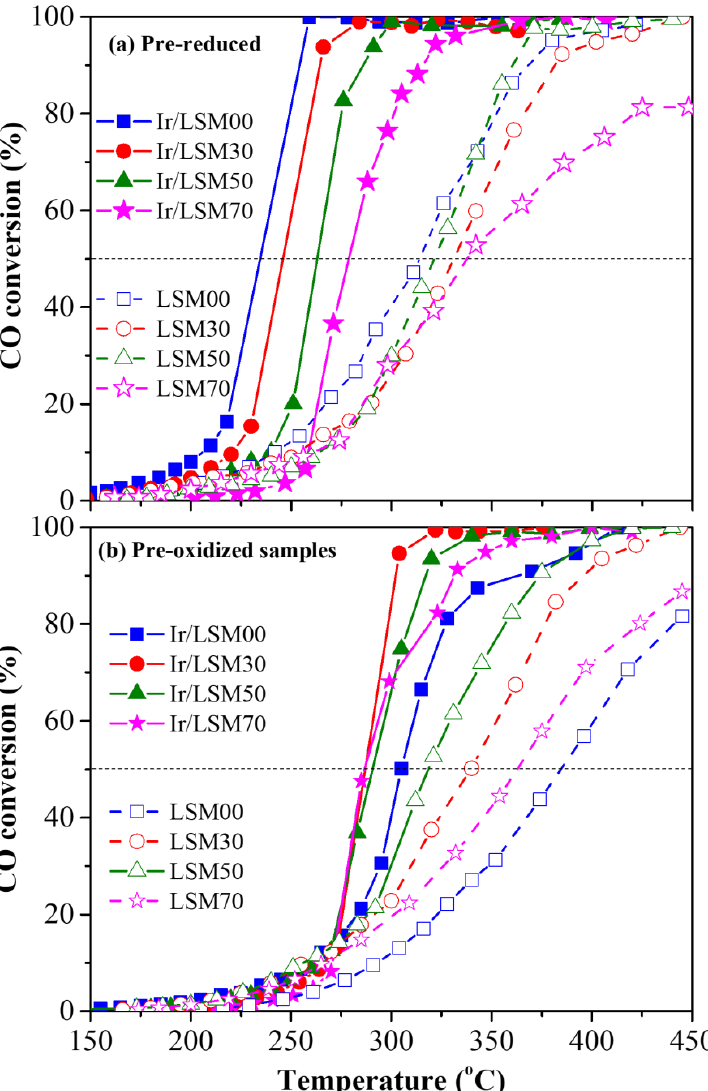
Figure 3. Conversion of CO as a function of temperature (light-off diagrams), for prereduced ( a ) and preoxidized ( b ) LSMx and Ir/LSMx catalysts. Experimental conditions: 1.0% CO, 5.0% O 2 , He balance at 1 bar, F T = 160 mL/min, catalyst mass m cat = 20 mg, wGHSV = 480,000 mL/g · h. Open symbols and dashed lines → LSMx; solid symbols and solid lines → Ir/LSMx).